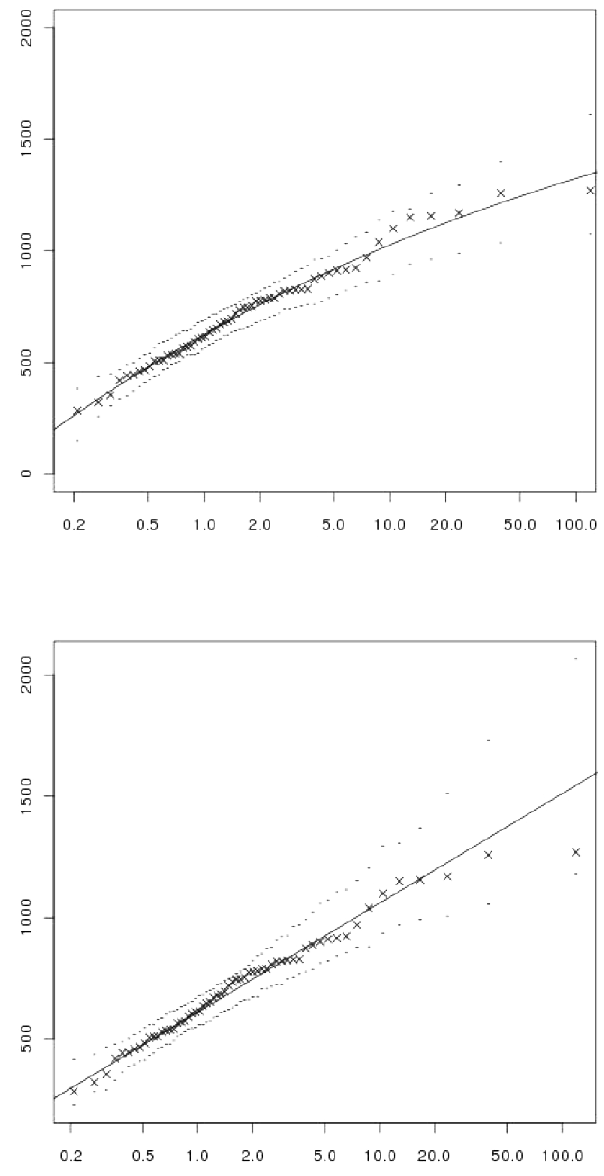
Figure 1. Return level plot (block maxima approach, maximum likelihood estimators). Top: assumption ξ (cid:54)= 0, bottom: assumption ξ = 0. Horizontally: − 1/log ( 1 − 1 /N) , logarithmic scale, vertically: estimated N -year return level. Continuous line: estimation using the GEV, crosses: sample points, dots: 95% confidence